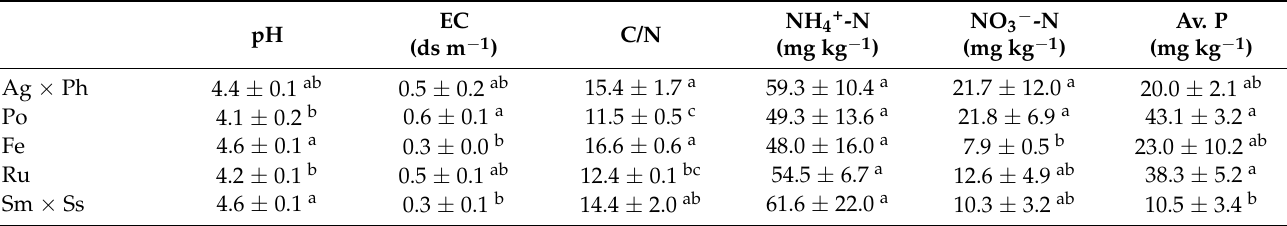
Table 2. Chemical properties of